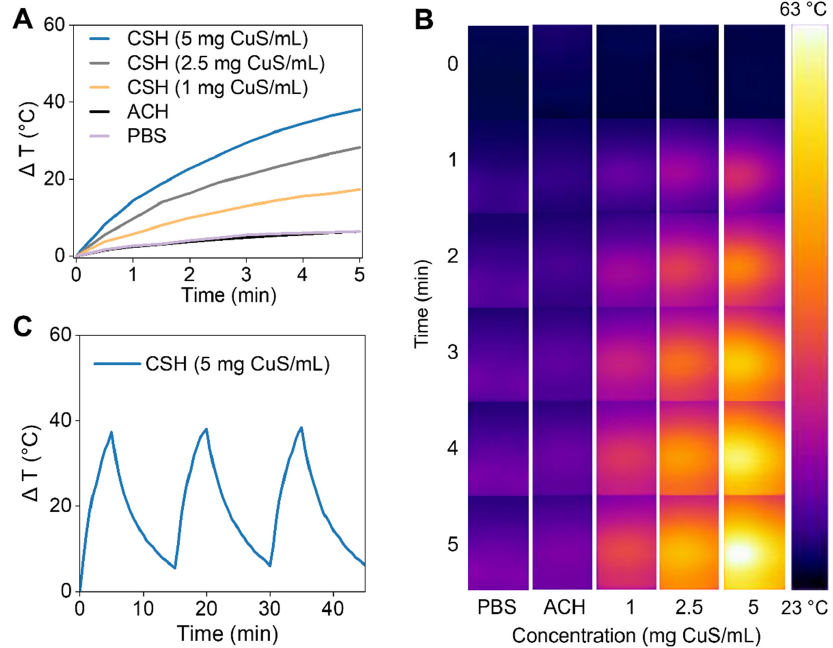
Figure 3. ( A ) Photothermal heating curves of PBS, ACH, and CSH irradiated by NIR-II laser (1064 nm, 1 W/cm 2 ). ( B ) The thermal images of PBS, ACH, and CSH under NIR-II laser irradiation taken by an infrared thermal camera. ( C ) The photothermal stability of CSH.